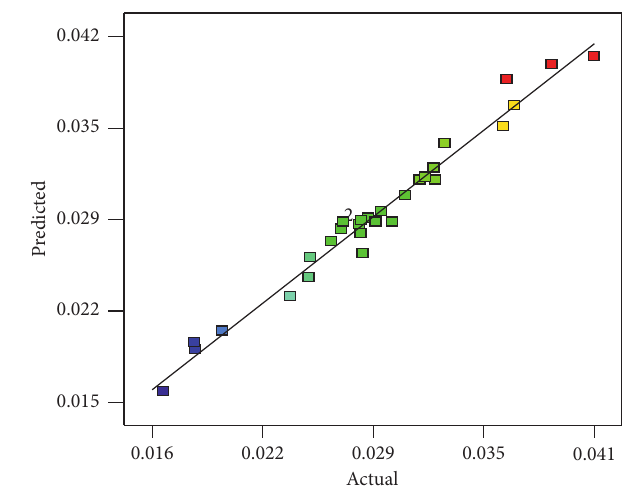
Figure 3: Correlation graph.